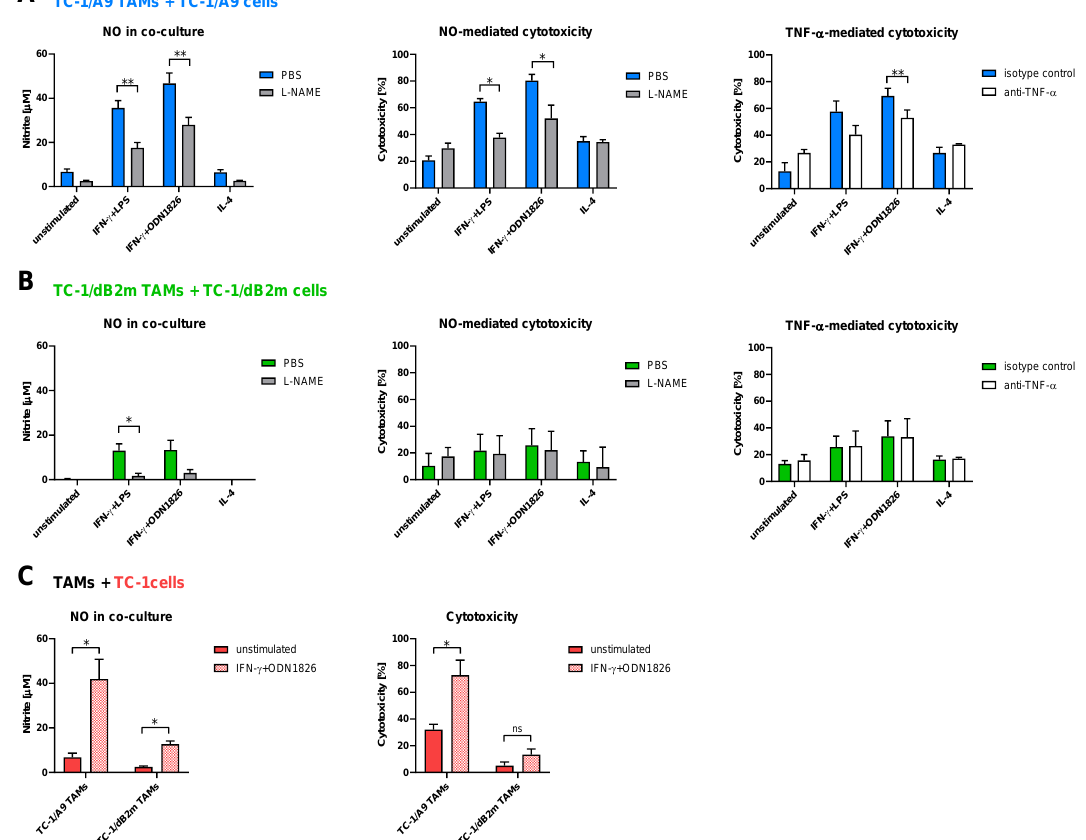
Figure 3. In Vitro cytotoxicity of TAMs against tumor cells. Co-cultures of TAMs with tumor cells were established and stimulated with IL-4 or IFN- γ + TLR agonist for 44 h. The unstimulated cells were used as a negative control. The influence of NO and TNF- α on cytotoxicity was tested with L-NAME and anti-TNF- α , respectively ( A , B ). Subsequently, the supernatants from co-cultures were collected and nitrite concentrations were measured with Griess reagent ( A – C ; left-hand graphs). Next, the cells were used for the MTT assay ( A – C ; middle and right-hand graphs). Co-cultures were set in the following combinations: ( A ) TAMs from TC-1/A9 tumors plus TC-1/A9 cells; ( B ) TAMs from TC-1/dB2m tumors plus TC-1/dB2m cells; ( C ) TAMs from TC-1/A9 tumors or TC-1/dB2m tumors plus TC-1 cells. Columns indicate mean of three independent experiments; bars: ± SEM; ns; non-significant, * p < 0.05, ** p < 0.01.